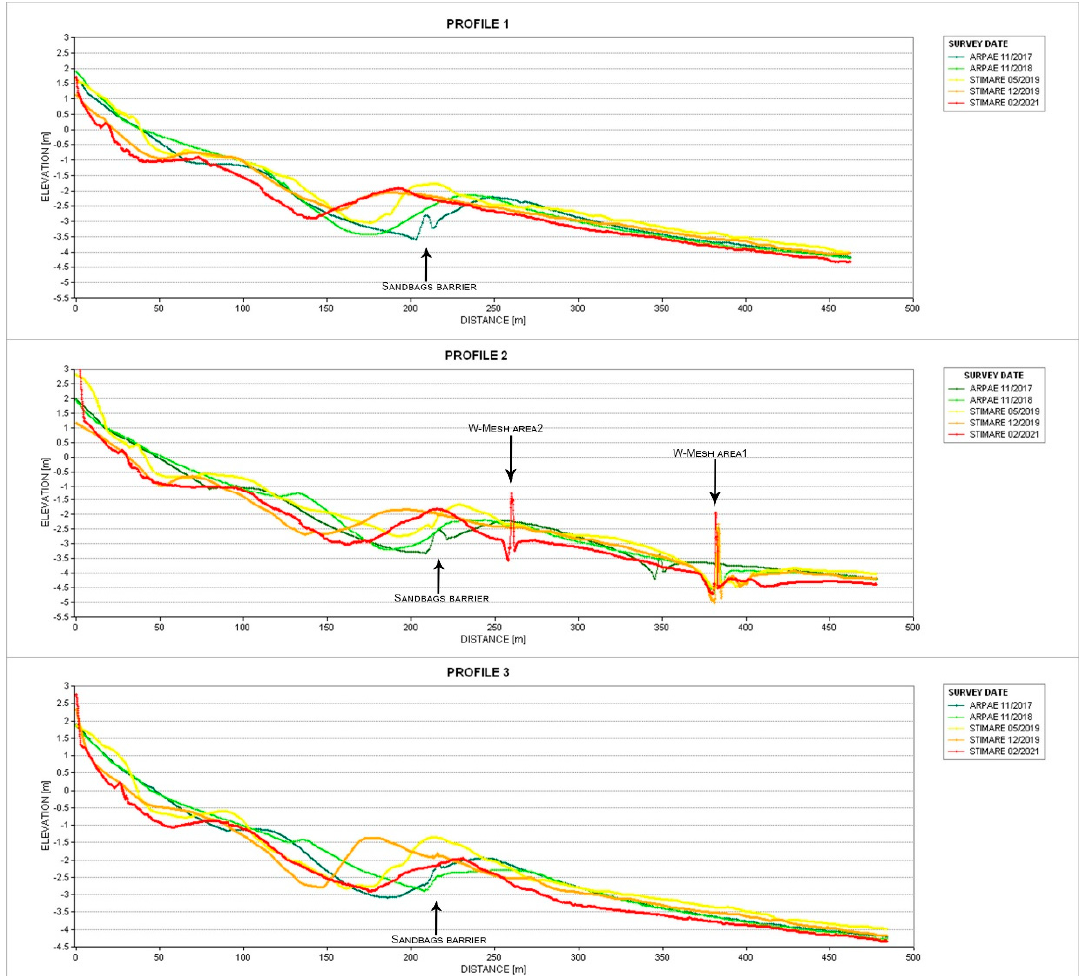
Figure 10. Beach section comparison along NE–SW oriented profiles (see Figure 9 for profile location). The position of the sandbag barrier and of the W-Mesh modules is indicated with arrows.